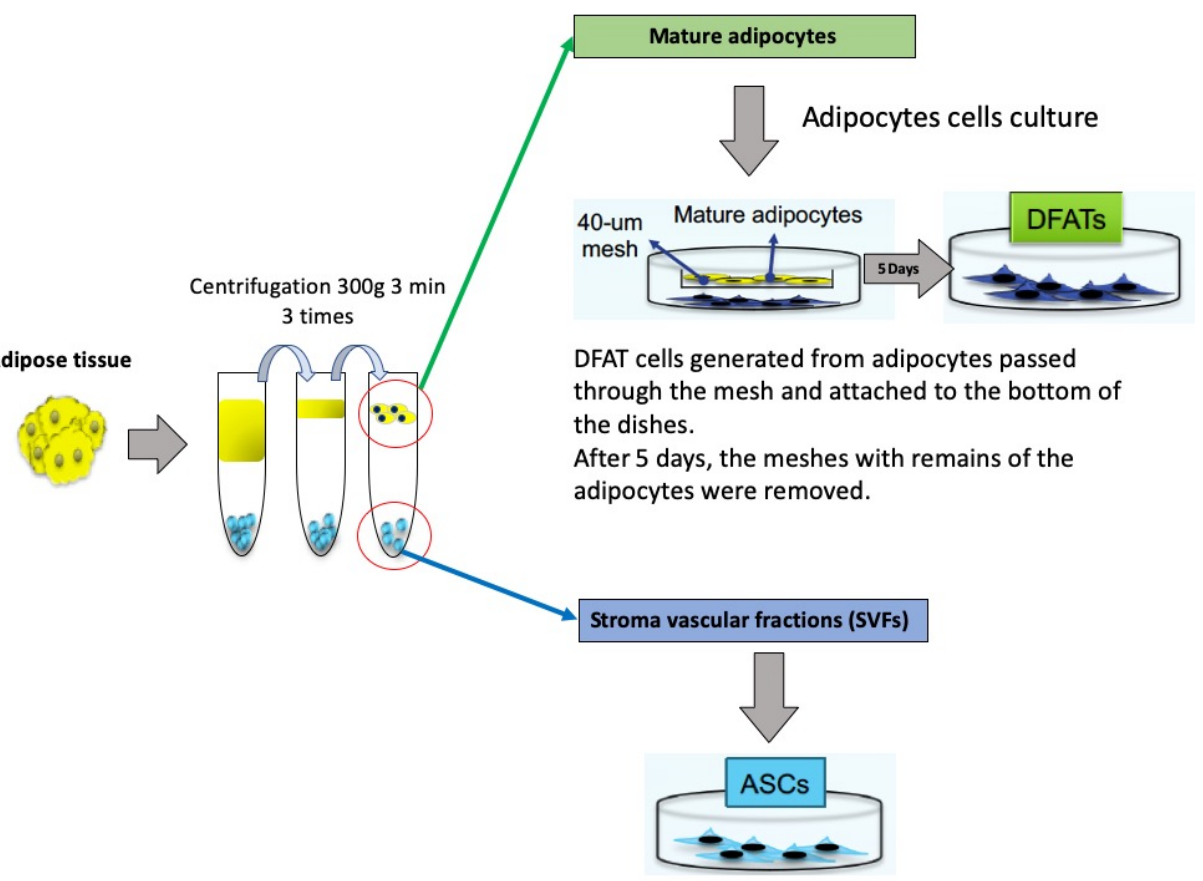
Figure 1. Isolation of DFAT cells and ASCs. The adipose tissue was minced into small pieces and then dissociated in a collagenase and dispase solution. After centrifugation, adipose tissue was separated into two layers. One was the upper layer containing mature adipocytes, and the other was the bottom layer containing cells of the stromal vascular fraction (SVF). Each layer of collected cells was cultured.